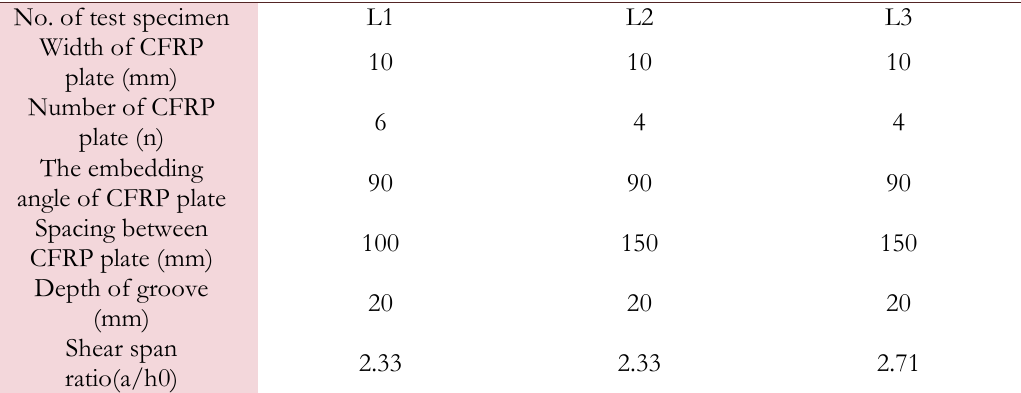
Table 2: The parameters of the verified beams.